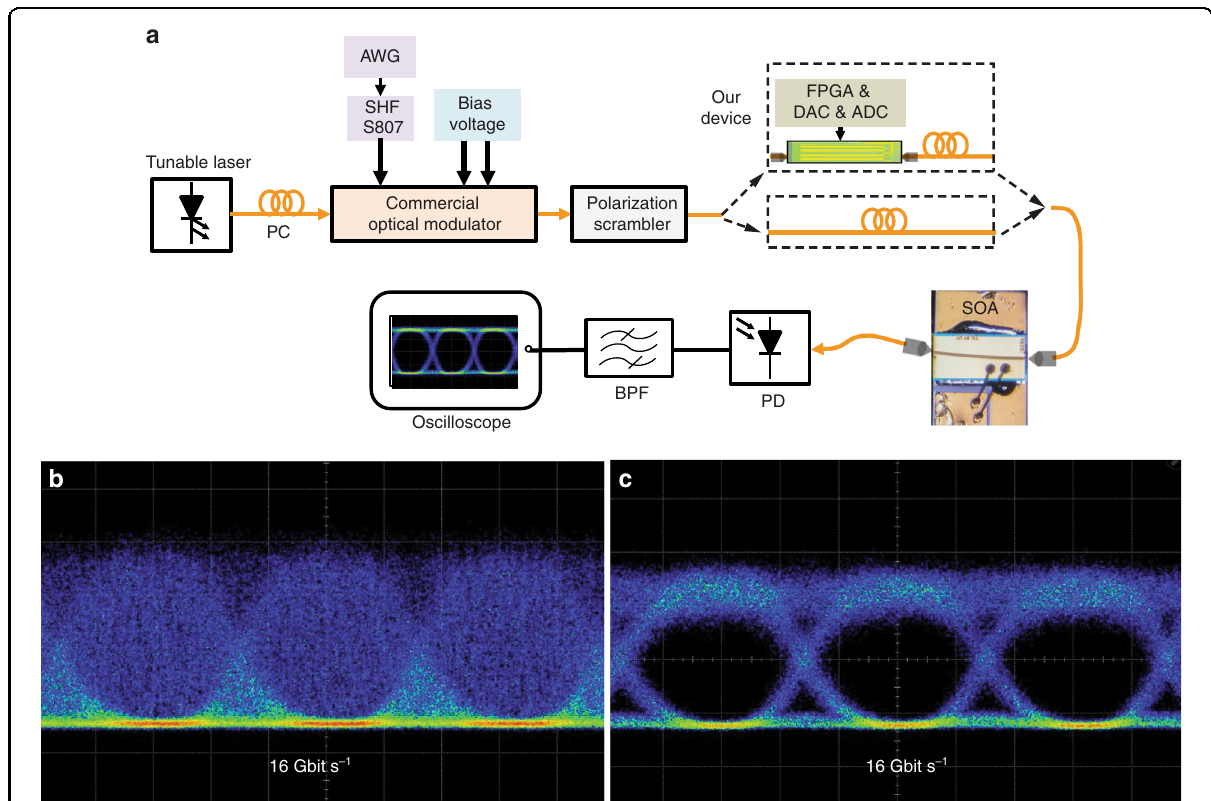
Fig. 6 The experiment for demonstrating the application in the communication system. a A schematic of the experiment setup. PC polarization controller based on the coiling fi ber, AWG arbitrary waveform generator, FPGA fi eld programmable gate array, SOA semiconductor optical ampli fi er, PD photodetector, BPF band pass fi lter, DAC digital-to-analog converter, ADC analog-to-digital converter. b and c are eye diagrams in the cases of the systems including and excluding our on-chip endless automatic polarization controlling device,